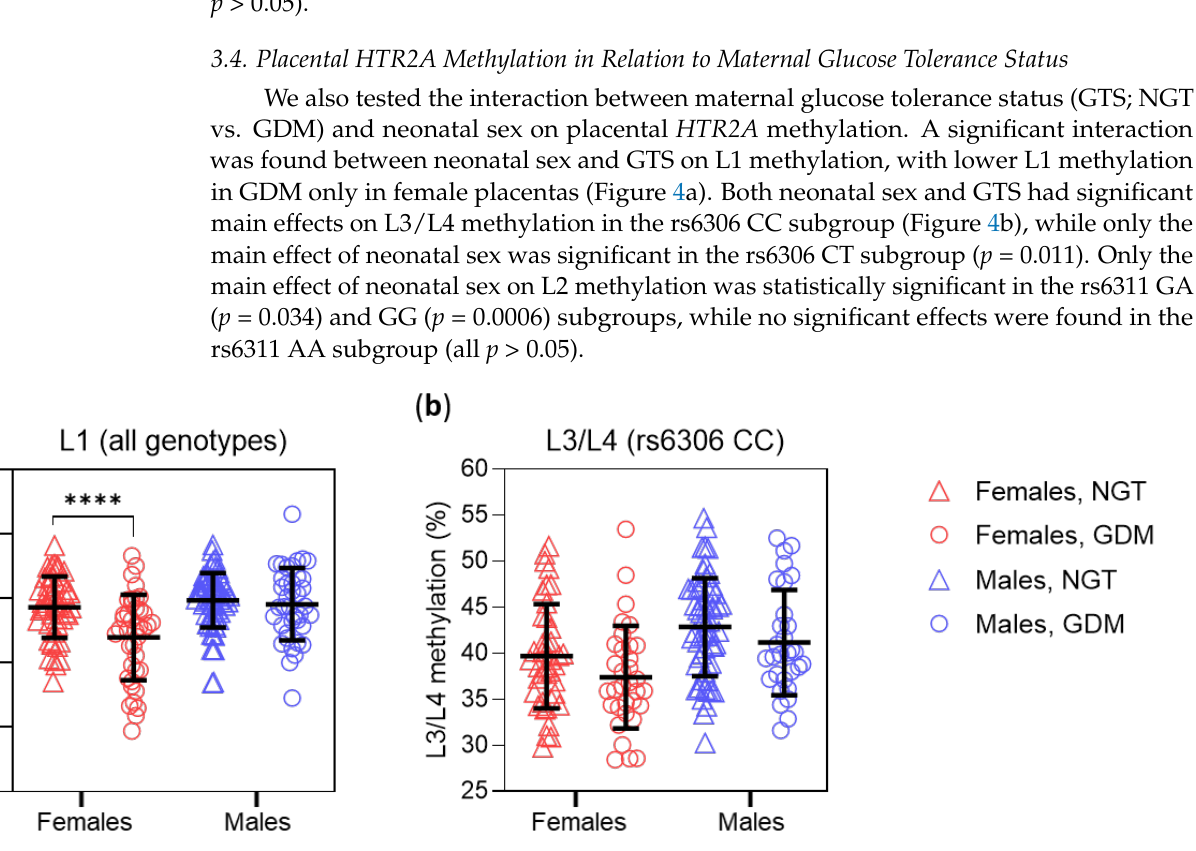
Figure 4. Placental HTR2A methylation as a function of neonatal sex and maternal glucose tolerance status (GTS). Individual values are shown, and lines indicate means and standard deviations. Sta- tistical analyses used two-way ANOVA. ( a ) L1 methylation in the total sample ( n = 194; p = 0.008 for interaction of GTS and sex). ( b ) L3/L4 methylation in rs6306 CC homozygotes ( n = 163; p = 0.0002 for main effect of sex, p = 0.003 for main effect of GTS). NGT — normal glucose tolerance, GDM — gestational diabetes mellitus. **** p < 0.0001 (Sidak’s post-hoc test).